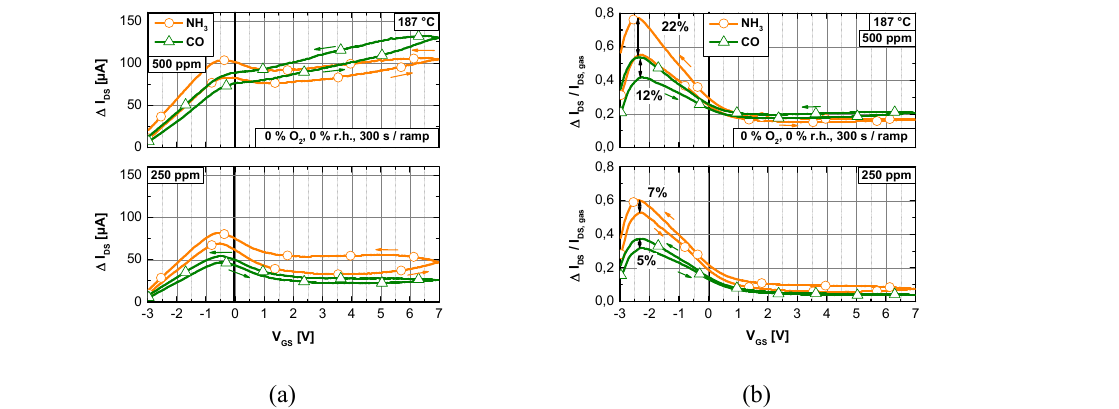
Figure 9. Influence of the gas concentration on the hysteresis in di ff erence signal (a) and in di ff erence signal relative to the absolute signal in gas (b).